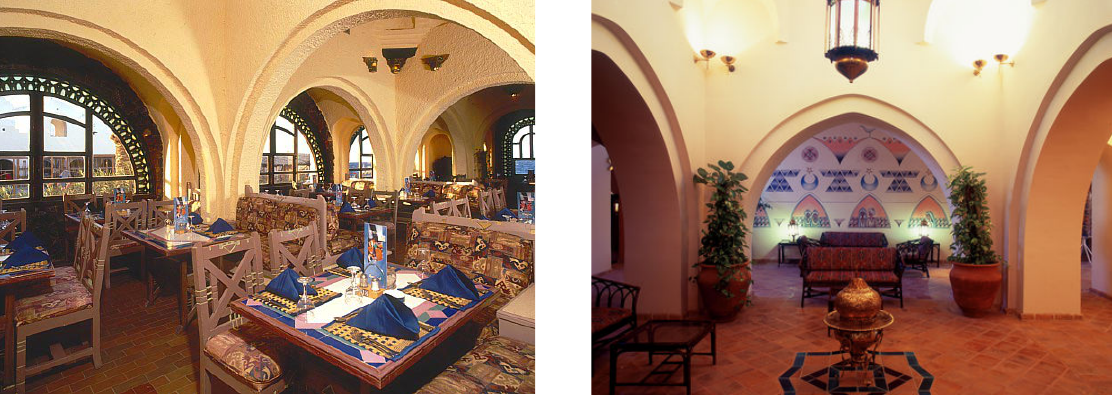
Figure (3): Examples Given to students that reflect Heritage factors on interior architecture. Source: